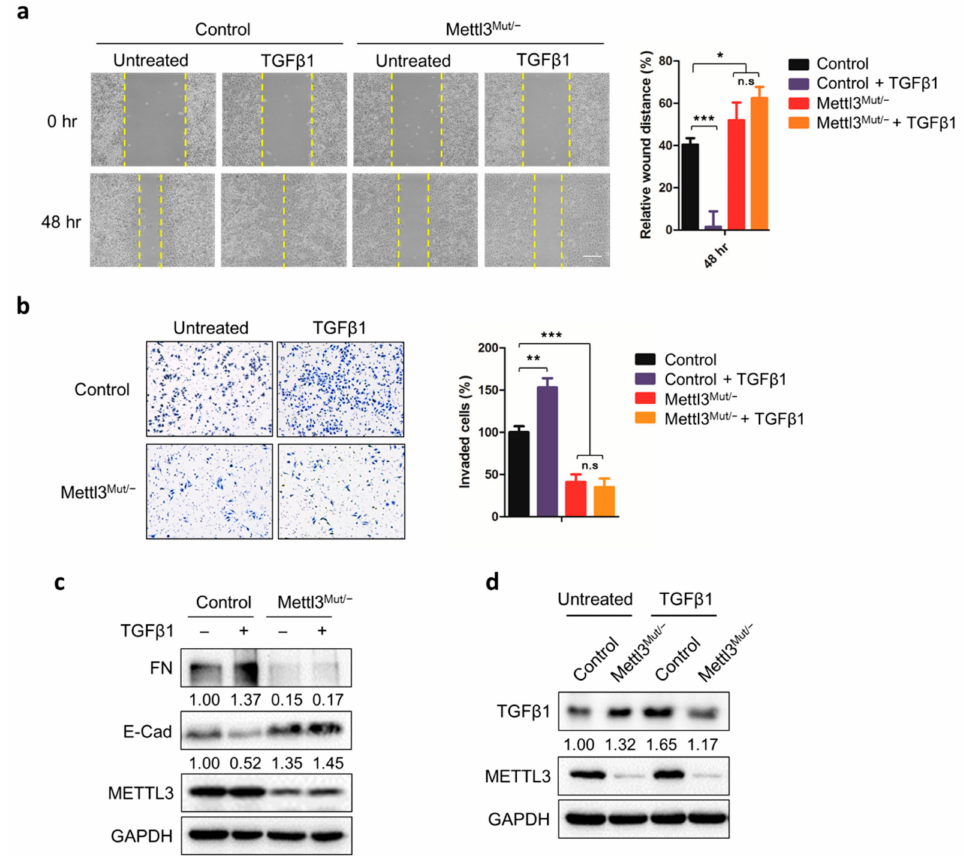
Figure 1. METTL3 regulates EMT and TGF β 1 expression in HeLa cells. ( a ) Control and Mettl3 Mut / −